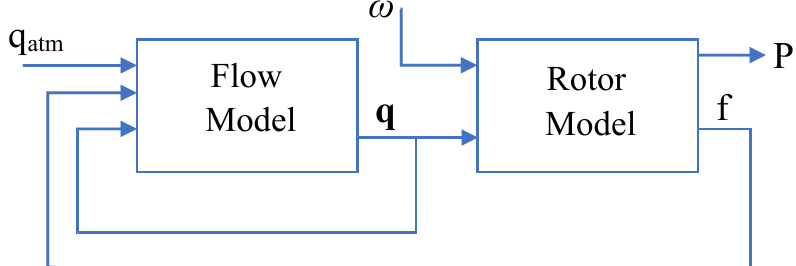
Figure 2. Block diagram of wind farm